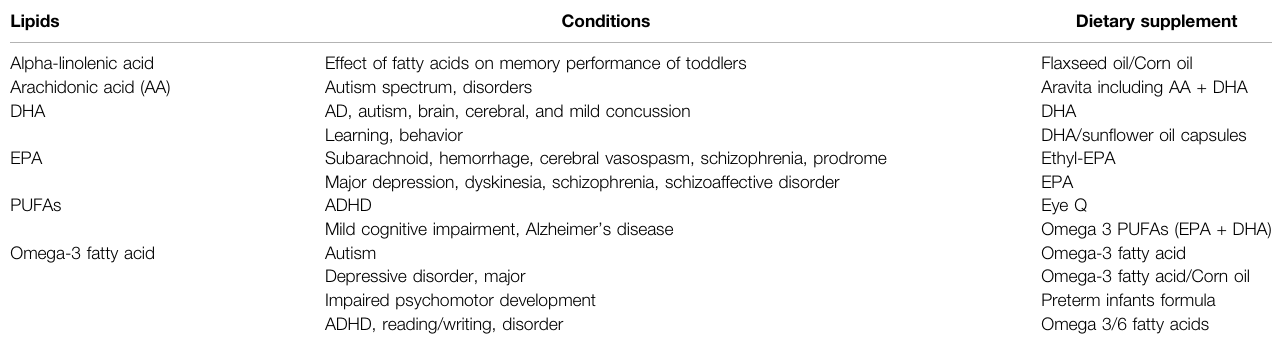
TABLE 6 | Clinical studies completed on lipids with protective effects of neurodegenerative